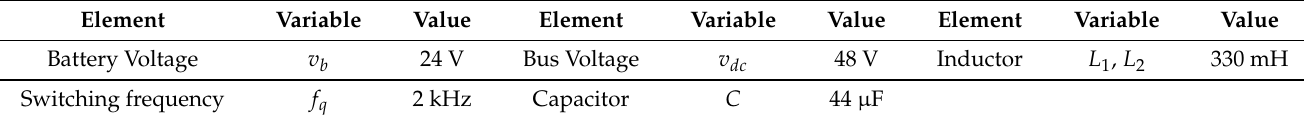
Table 1. Interleaved boost converter